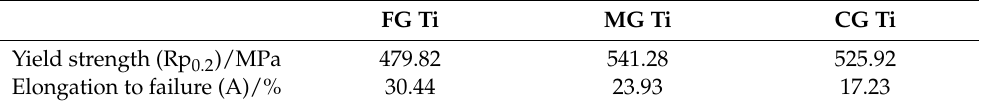
Yield strength (Rp 0.2